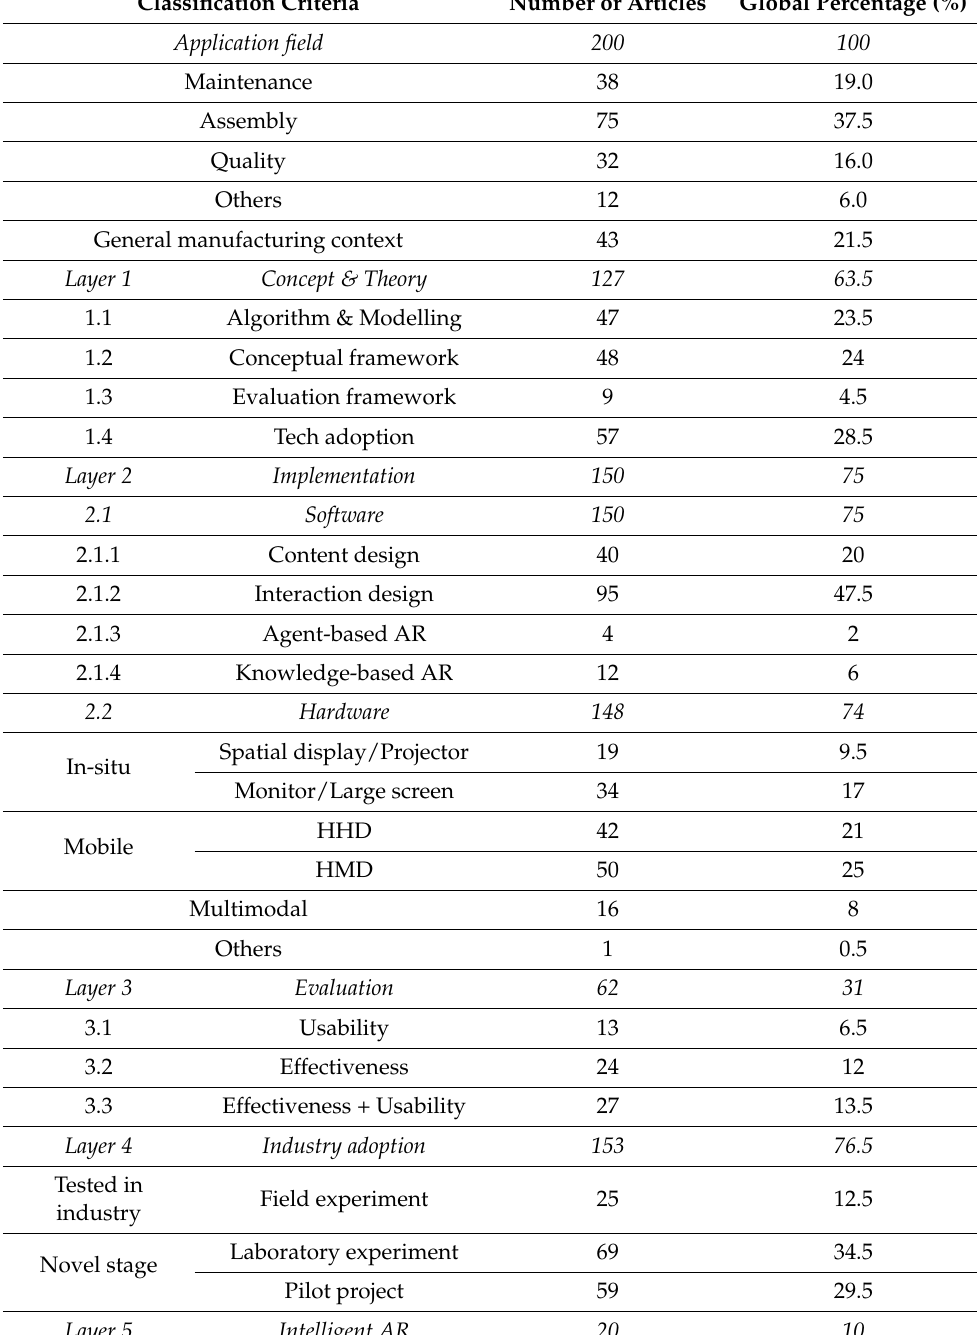
Table 8. Number of articles classified by the